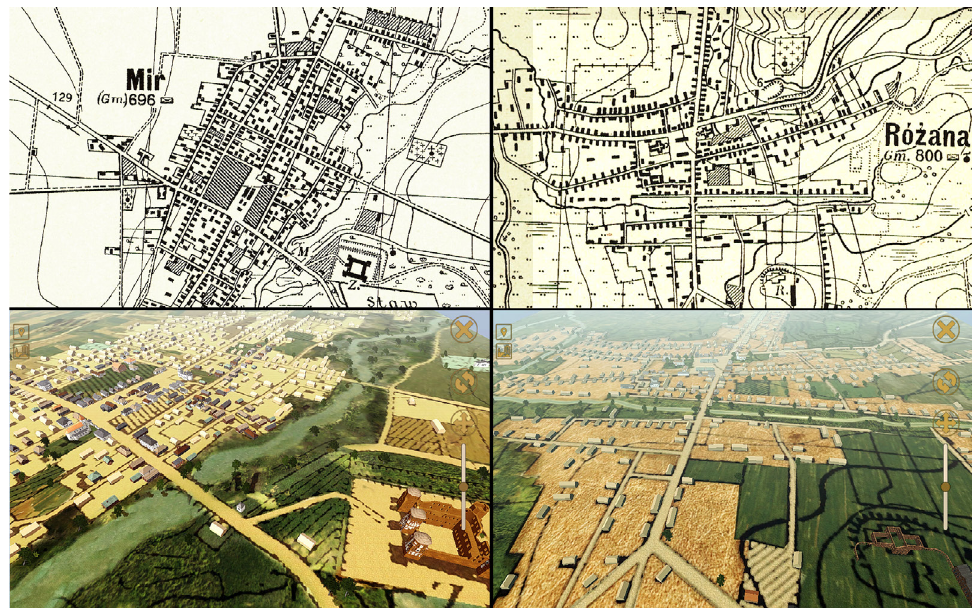
Fig. 7. MGI’s 1:25,000 detailed map and corresponding 3D mock-ups: a) sheet P35-S43-A Mir; b) sheet P37-S40-D Różana. Map source: The University of Chicago Library (via Mapster), public domain. 3D mock-ups: Pavel Sanko & Konstantin Zobnin